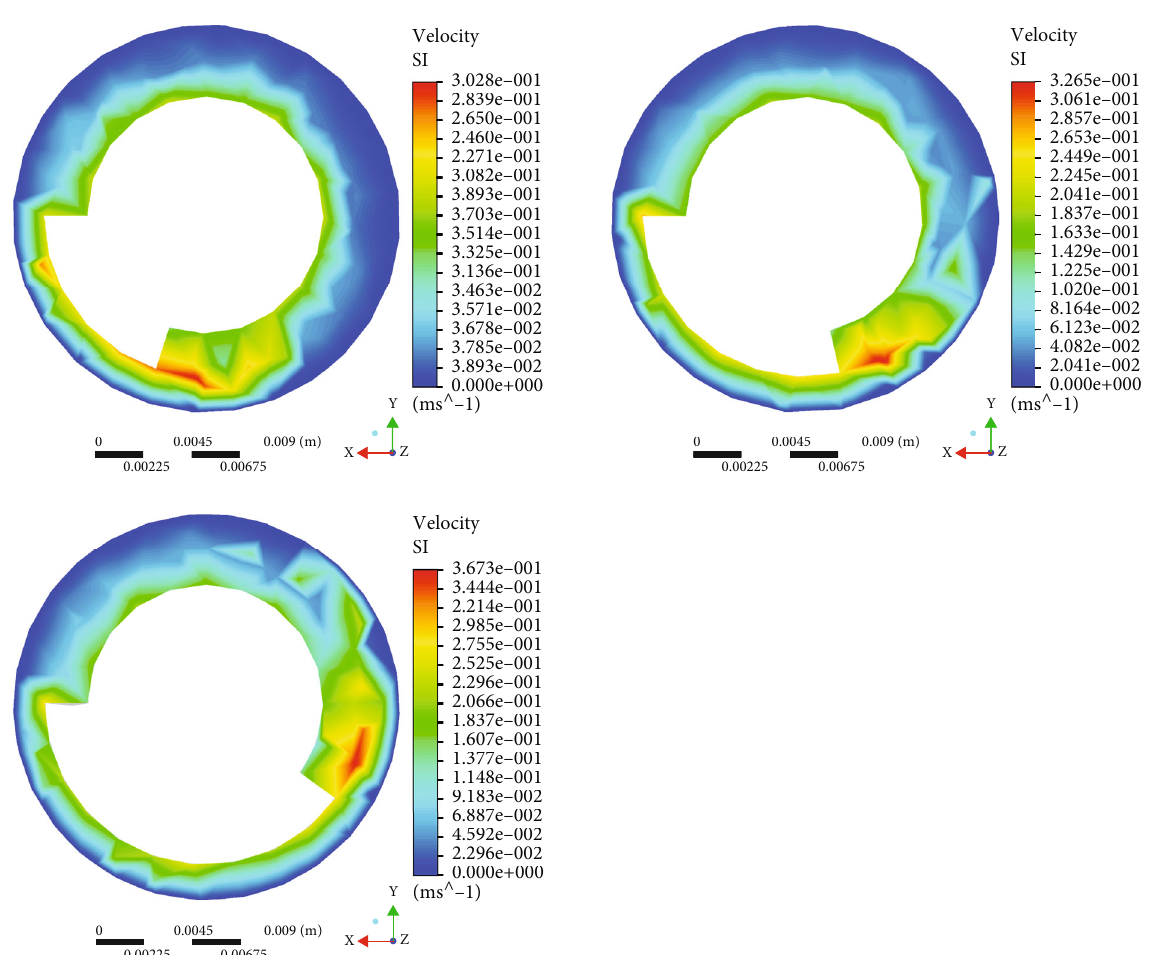
Figure 4: Simulation of inlet plane velocity pro fi le of di ff erent capsule robots at the same rotational